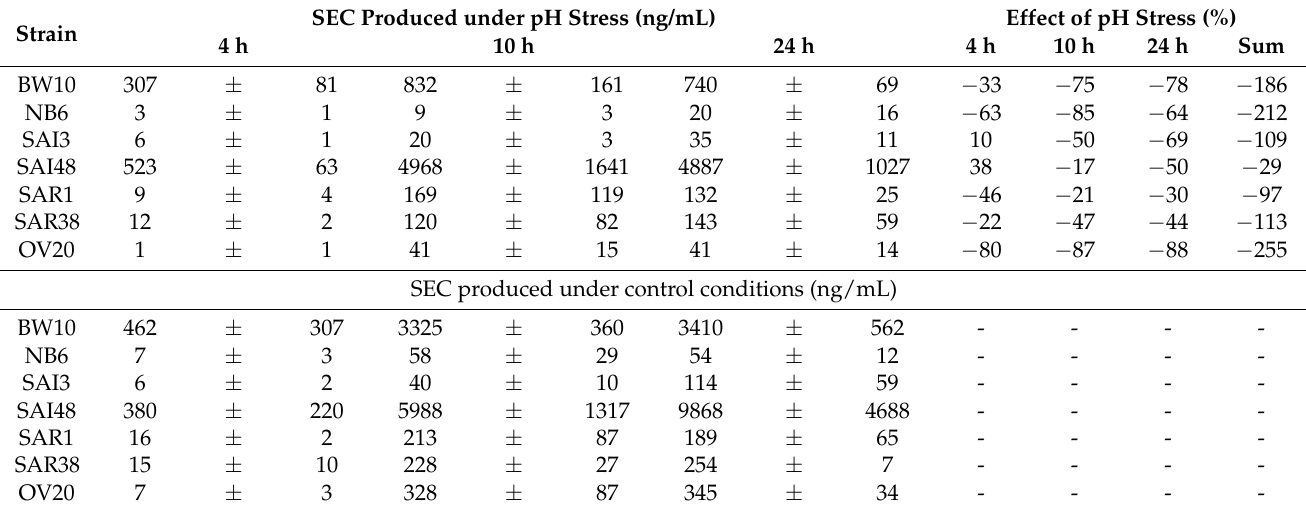
Table 2. Effect of pH stress on SEC expression. Absolute values in ng/mL including standard deviation. Effect is shown